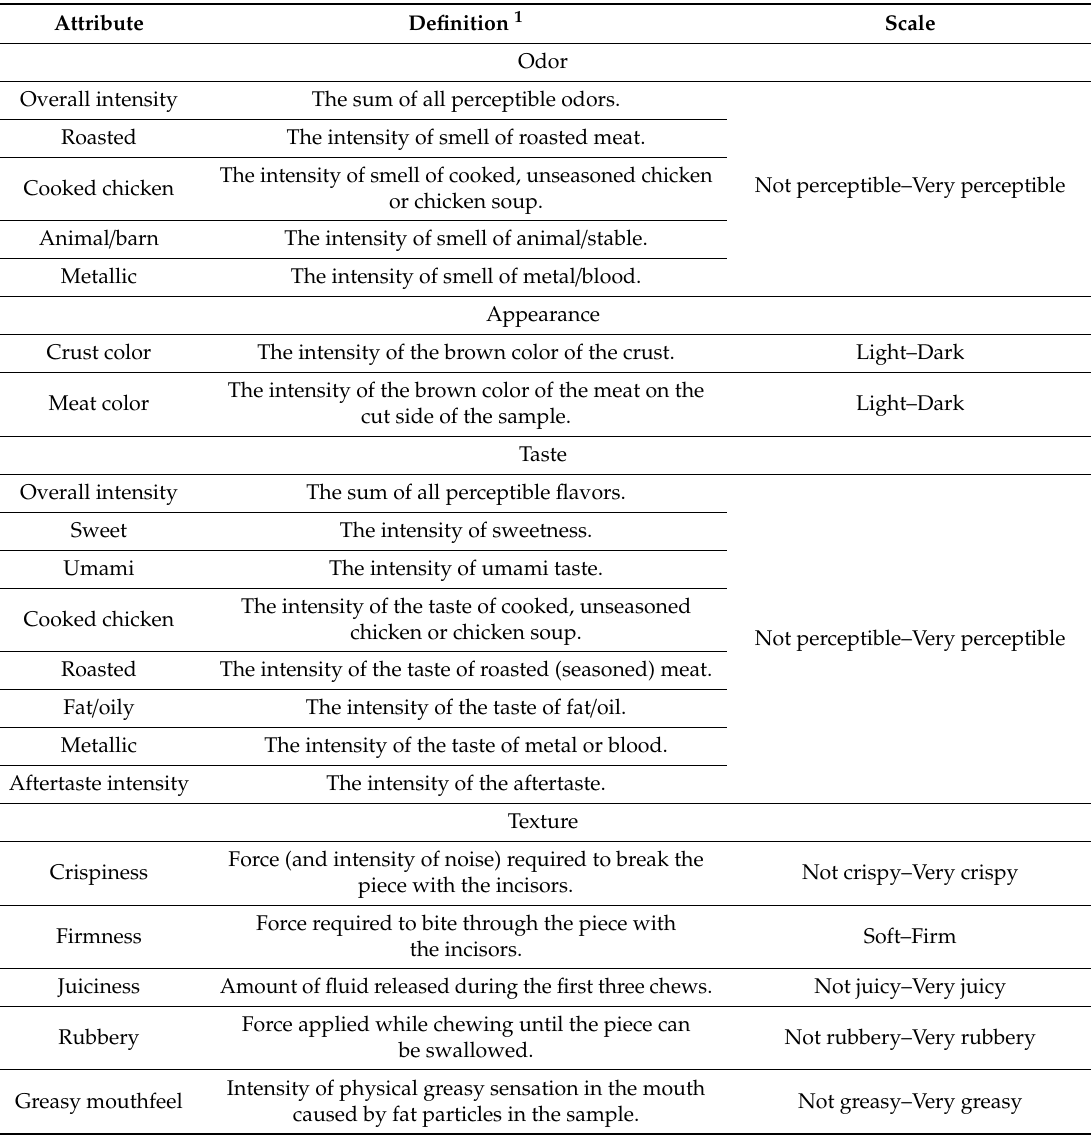
Table A2. Sensory attributes, definitions, and scales used to evaluate leg